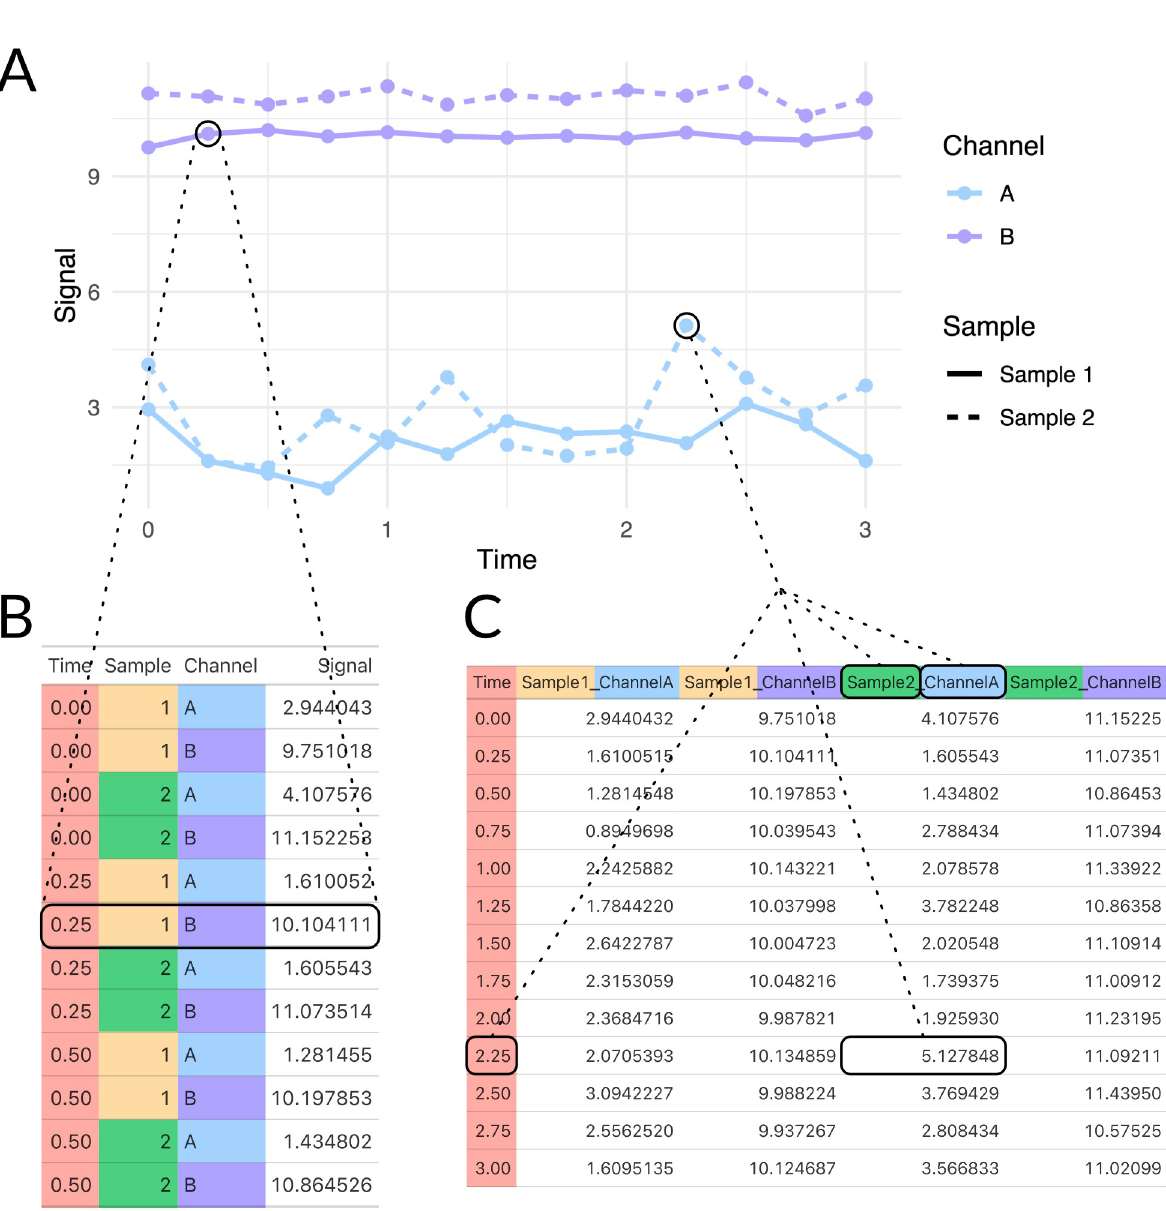
Fig 2. Appia data formats. A: Example data plot of generated data. B: The data plotted in A, represented in “tidy” format. Each column represents a variable, meaning each row represents a single observation (or a point in A). C: Wide format. One column represents a variable, and the other columns represent groups of observations along that first variable. This means that variables beyond the first must all be stored in the column headers, so information about a single observation is spread throughout the table, but the table is more compact. Both “tidy” and wide data are produced by